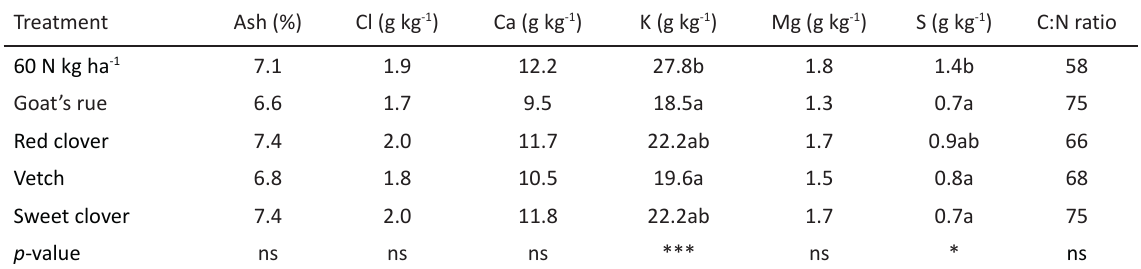
Table 3. Ash content and mineral element composition of Jerusalem artichoke treated with N fertilizer or intercropped with legumes during two growing seasons (2009 and 2010) in Helsinki, Finland. Data shown are means, n = 8. Treatment